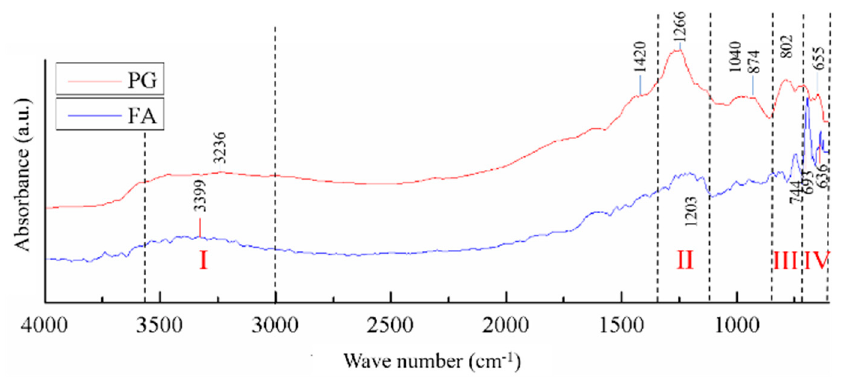
Figure 11. FTIR spectra of FA and PG.